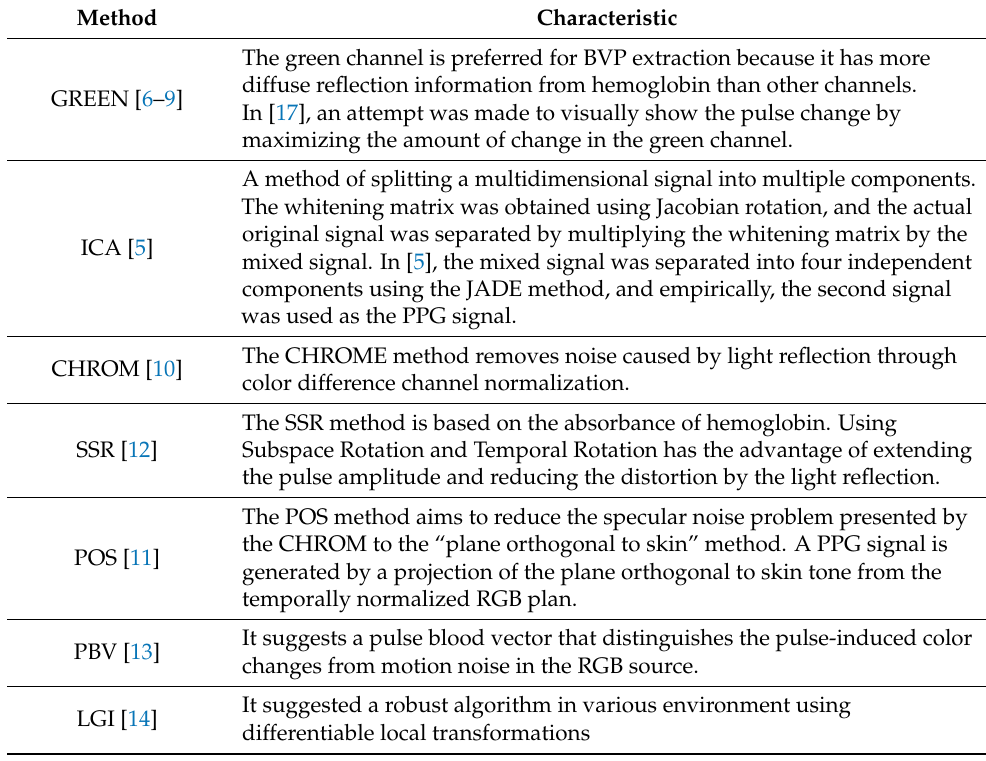
Table 1. Summaries of representative rPPG algorithms.